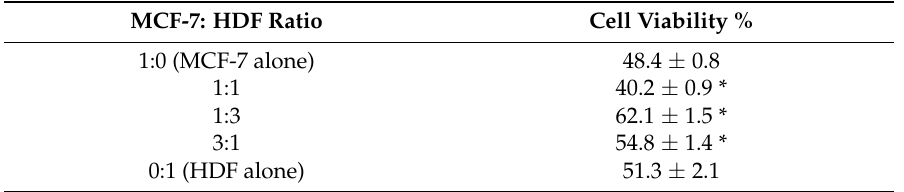
Table 2. Antiproliferative effect of 200 nM PCX solution on human breast cancer cell: human dermal